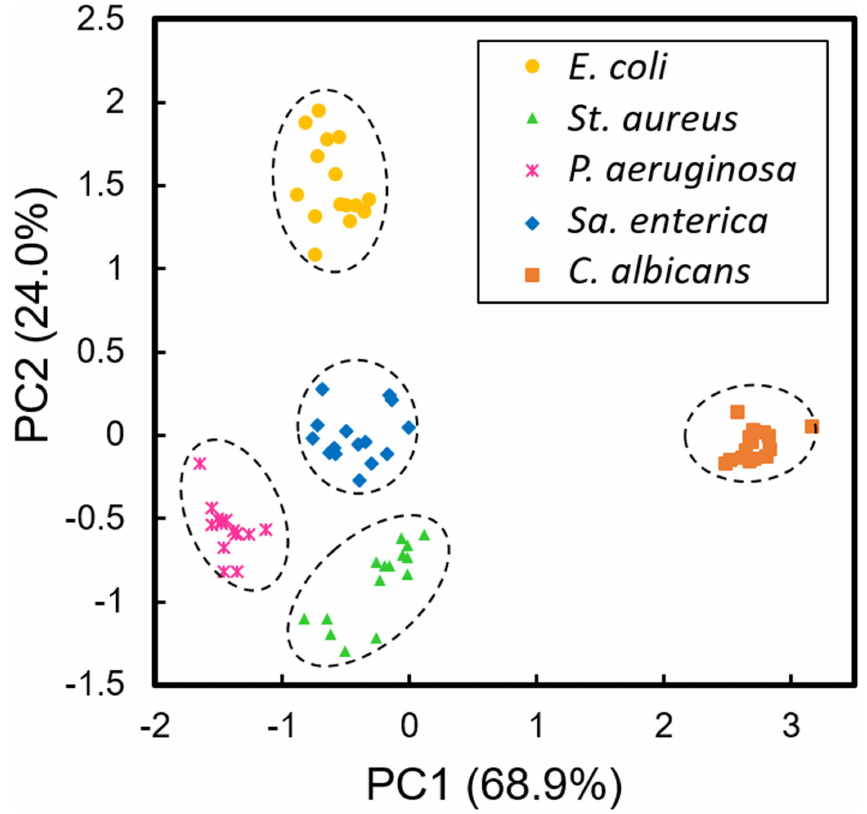
Fig 3. Discrimination results on E . coli , St . aureus , P . aeruginosa , Sa . enterica , and C . albicans based on lensless images. Principalcomponentanalysis(PCA) of maximum specific growth rate ( μ max ), colony appearance time (t a ), and relative intensity (I) extracted from lenslessimages of 15 microcolonies of 5 microbes. Dashed circles represent the clusters generatedby k-means cluster analysis.Data points of 15 coloniesof the each microbialspecies were obtainedfrom two independent culture experiments using different set of the LB-agerchamberand CMOS sensor. Contributionratios (%) of PC1 and PC2 are shown,